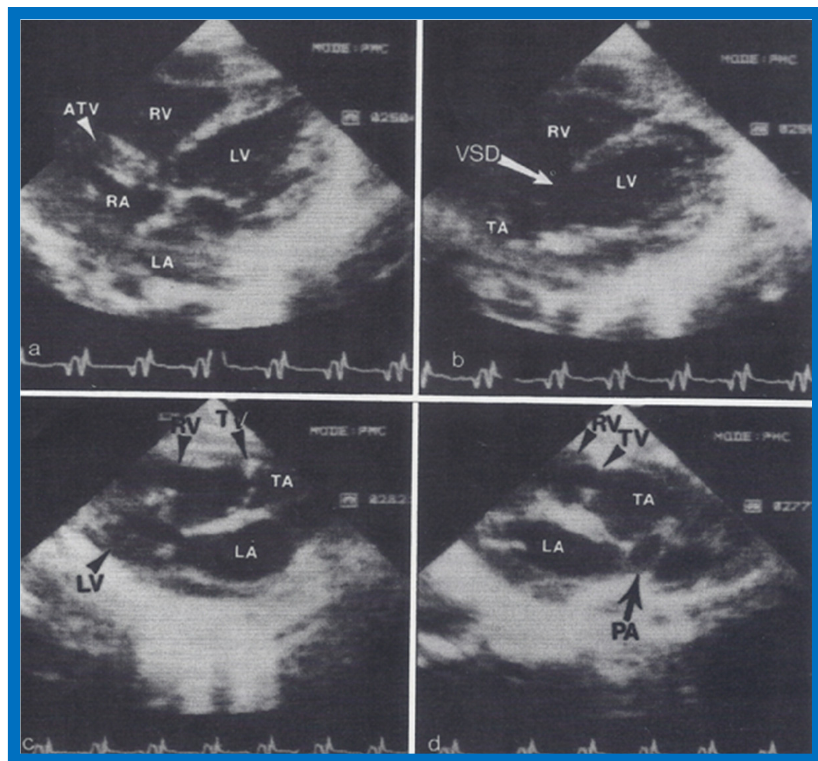
Figure 22. Selected video frame from precordial long axis view with color flow mapping of another neonate with tricuspid atresia and transposition of the great arteries illustrates the left atrium (LA), left ventricle (LV), a small right ventricle (RV) and a moderate sized ventricular septal defect (VSD). The vessel coming off of the LV bifurcates into left (LPA) and right (RPA) pulmonary arteries. Reproduced from Rao P.S. [39].